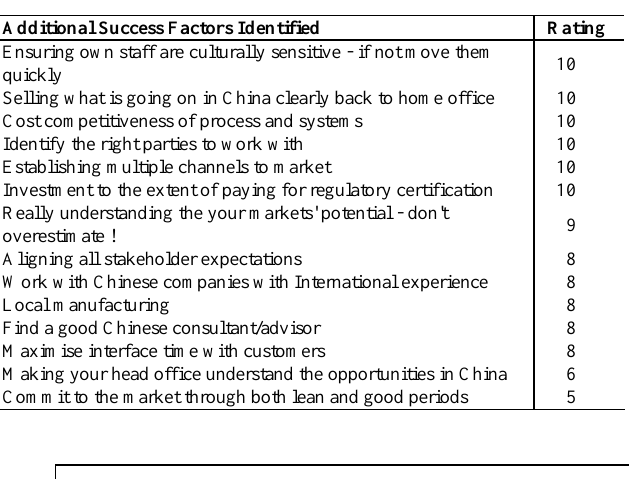
Table 2: Additional success factors with inverted ratings.